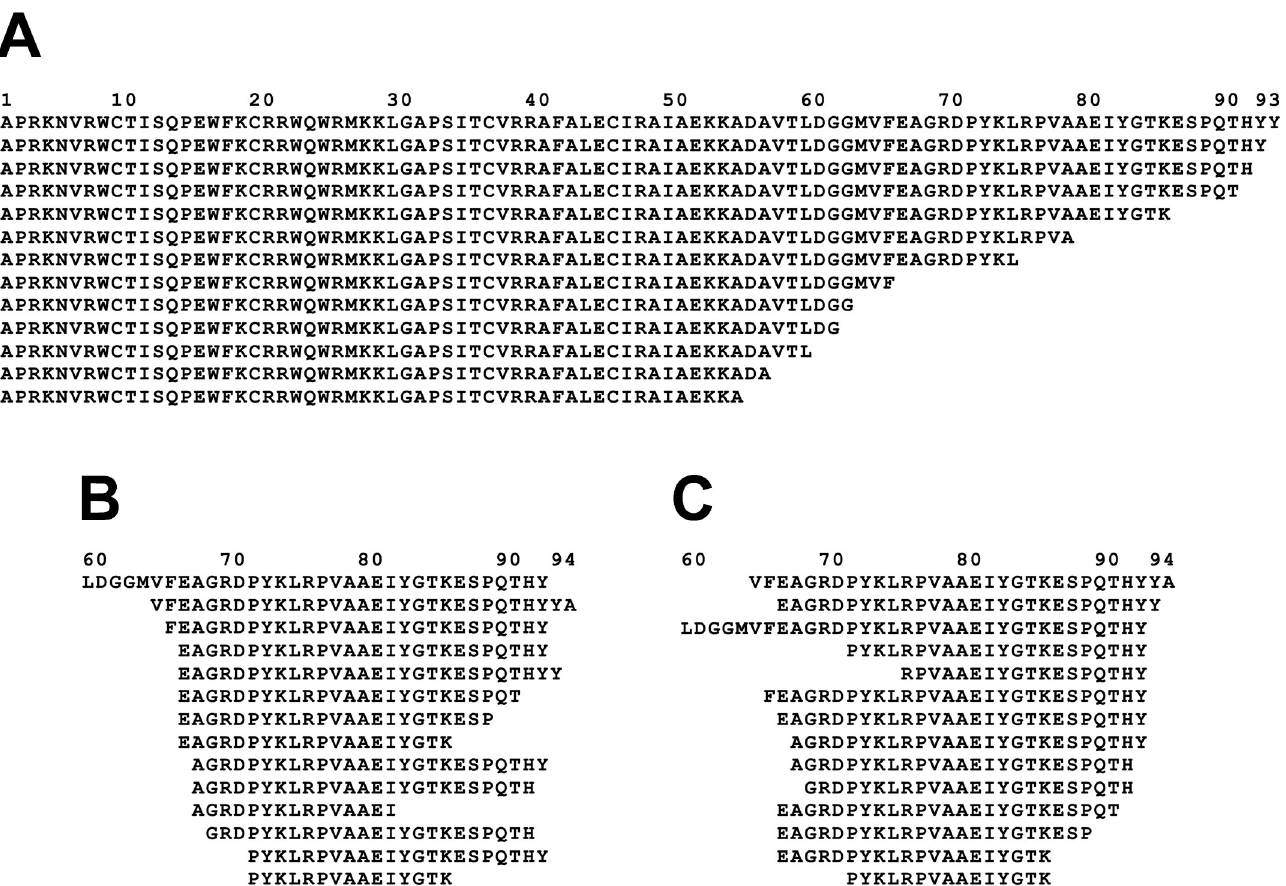
Fig 9. Evidence for exopeptidase processing of fragments. In panel A, a subset of fragments all starting at the N-terminus of bLF are aligned to show a series of C-terminal truncations consistent with processing of the longest fragment by carboxypeptidase(s) or other C-terminal exopeptidases. In panels B and C, fragments from the region 59–94 within bLF are arranged to show that both N-terminal truncations (B) and C-terminal truncations (C) can occur in the same set of